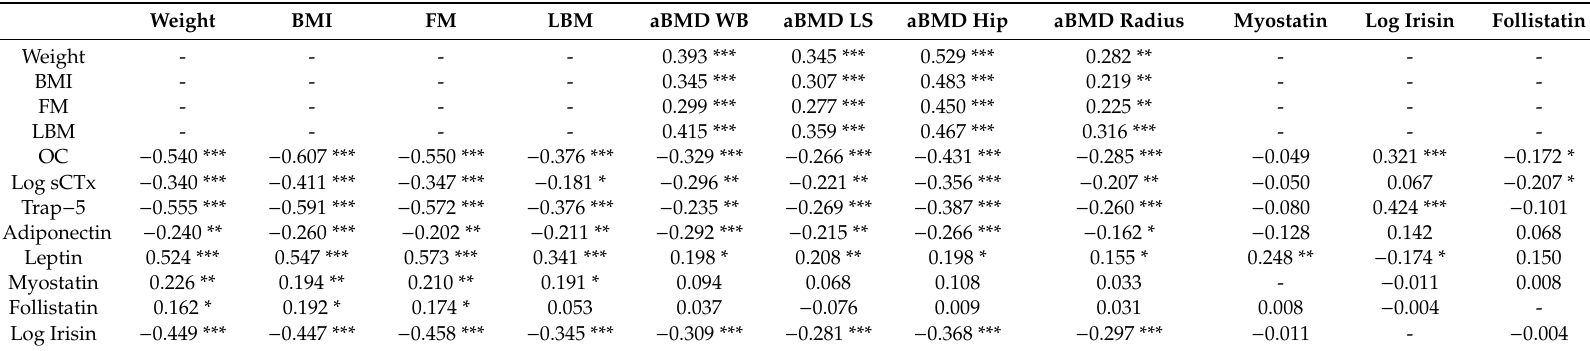
Table 2. Pearson correlation coe ffi cients of anthropometric parameters, bone turnover markers and myokines with areal bone mineral density adjusted for age.